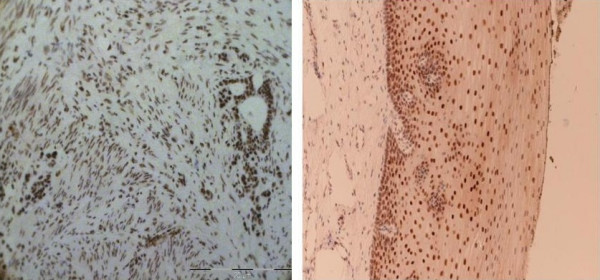
Immunohistochemical overexpression of oestrogen beta receptors.